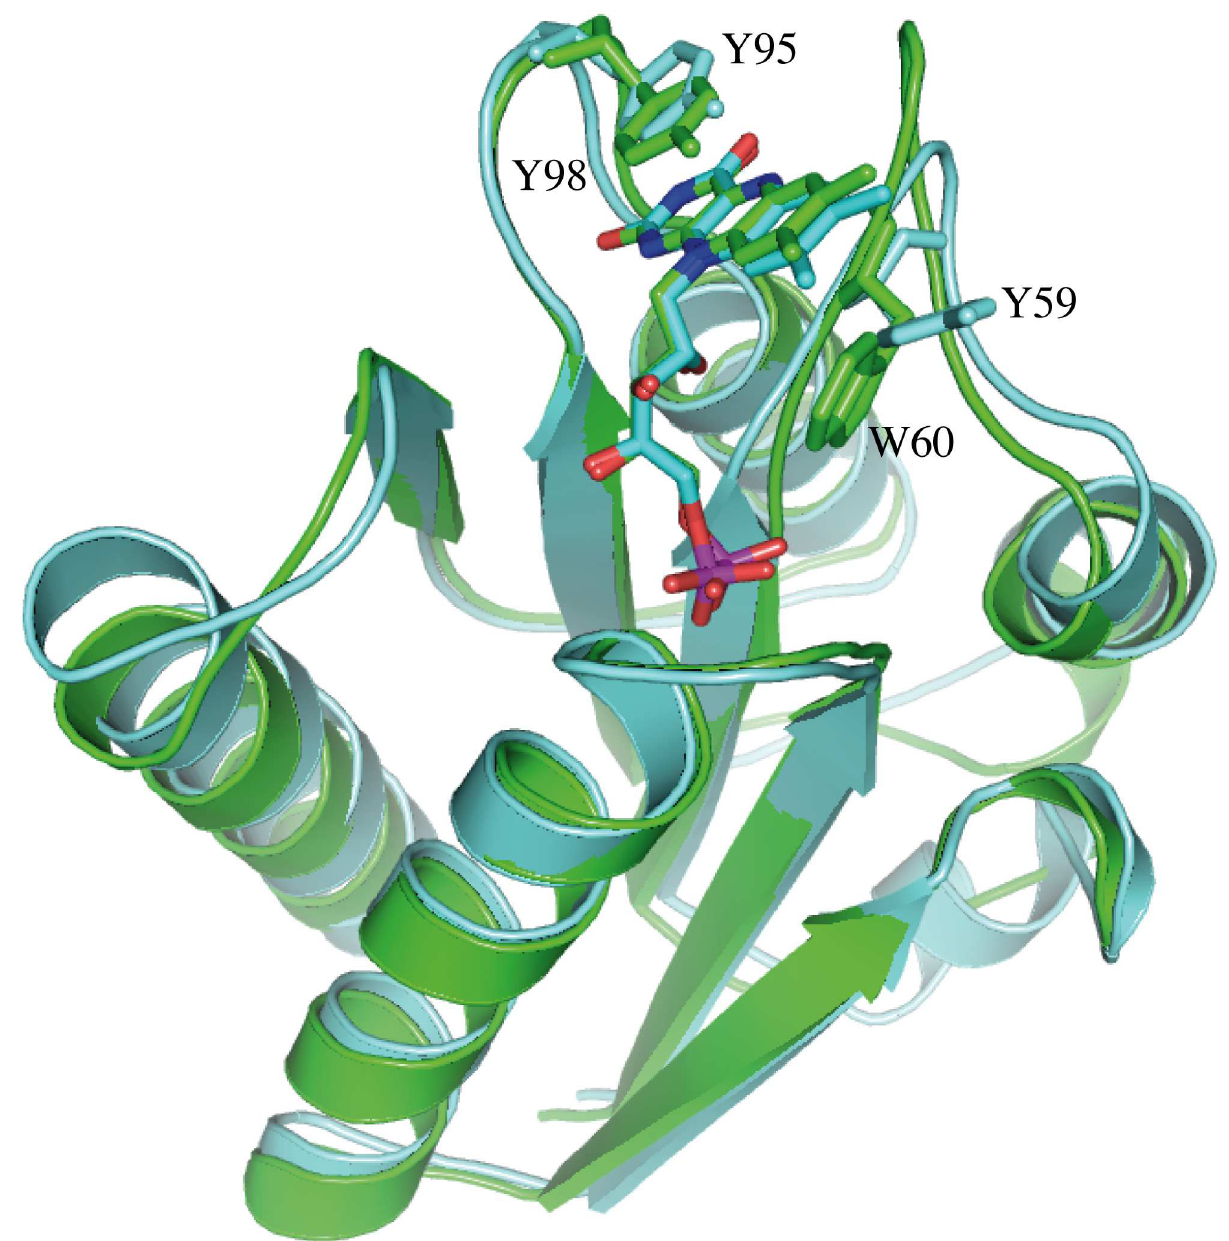
Fig 10. Structural comparison of the short flavodoxins from Desulfovibrio vulgari s (pdb id: 1j8q; ribbon and residues in green) and from Streptococcus pneumoniae (this work, pdb id: 5lji; ribbon and residues in cyan). The FMN cofactors of the two flavodoxins and the corresponding sandwiching aromatic residues (Y98 and W60 in Dv flavodoxin, and Y59 and Y95 in Sp flavodoxin) are shown in a stick